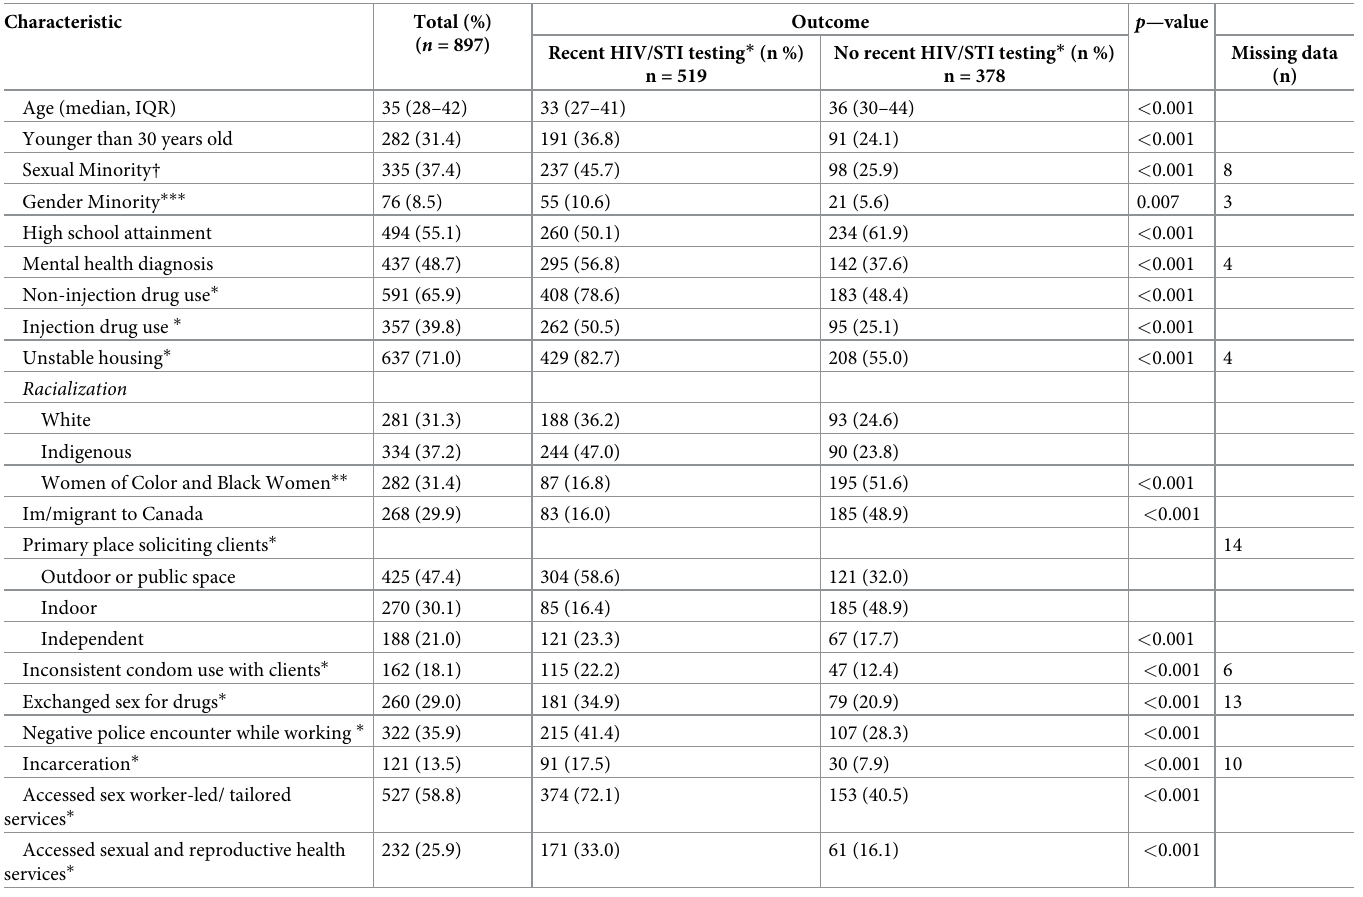
Table 1. Baseline individual and structural factors stratified by recent HIV/STI testing (last 6 months) at enrollment among women sex workers in Metro Vancou- ver, Canada (n = 897) AESHA,